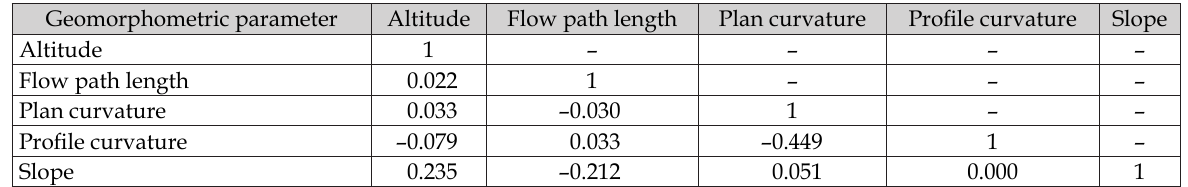
Table 2. Correlation matrix of geomorphometric